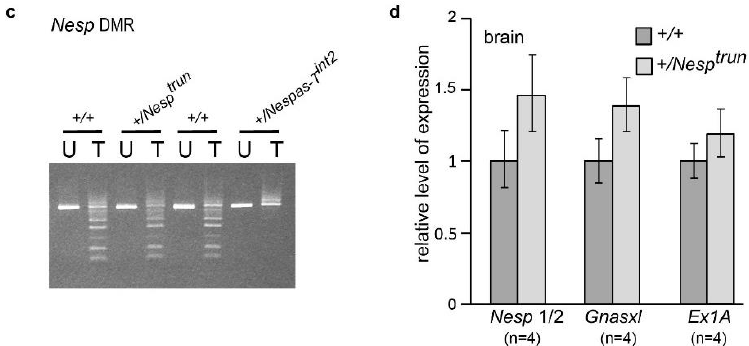
Figure 3. Transcription and methylation status of the Gnas cluster is unaltered on paternal inheritance of Nesp trun . ( a ) Schematic summary of the transcriptional and methylation status of Nesp and Nespas on the paternal allele in wild-type and +/ Nesp trun . The pA insertion will truncate Nesp if expressed. Row of filled circles, methylated allele; row of unfilled circles, unmethylated allele; ( b ) The level of Nespas exon 1 spliced onto exon 2 is unaltered in +/ Nesp trun ; ( c ) Methylation at the Nesp DMR is unaffected. PCR products from bisulphite-treated DNAs were separated on 3% agarose gels as either undigested (U) or digested with Taq 1 (T). Digestion products in the T lanes represent methylation of the CpG dinucleotide in the Taq 1 recognition sequence. Genomic DNA from +/ Nespas-T int2 in which both alleles were unmethylated was included as a negative control; ( d ) The levels of Nesp , Gnasxl and Exon1A ( Ex1A ) are